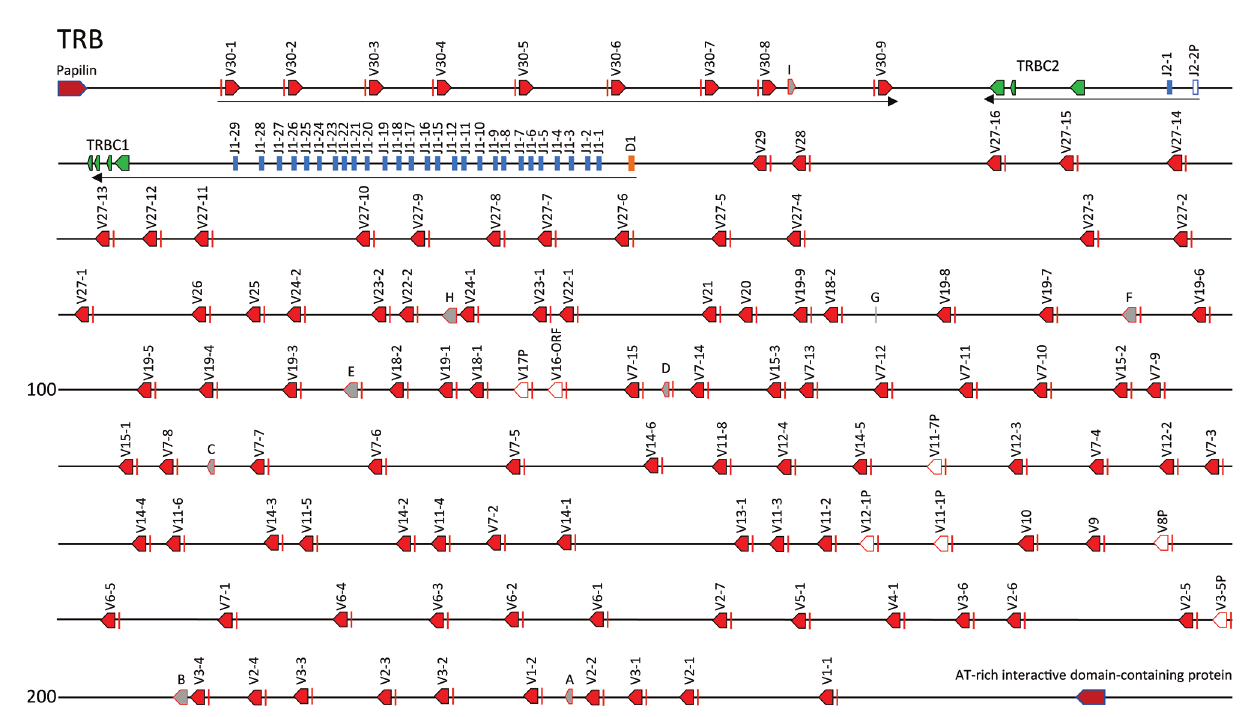
FIGURE 1 | The channel cat fi sh TRB locus. Schematic representation of the channel cat fi sh TRB locus. Red arrows mark the location and direction of transcription for each of the TRBV genes and green arrows mark the location of the TRBC1 and TRBC2 genes. The TRBJ genes are in blue and the TRBD gene is colored orange. Pseudogenes are in white and labeled, P. The fi ve TRB remnants are grey and labeled by letters A – E. The two genes that fl ank the locus, papilin and AT- rich interactive domain-containing protein (ARID-1) are